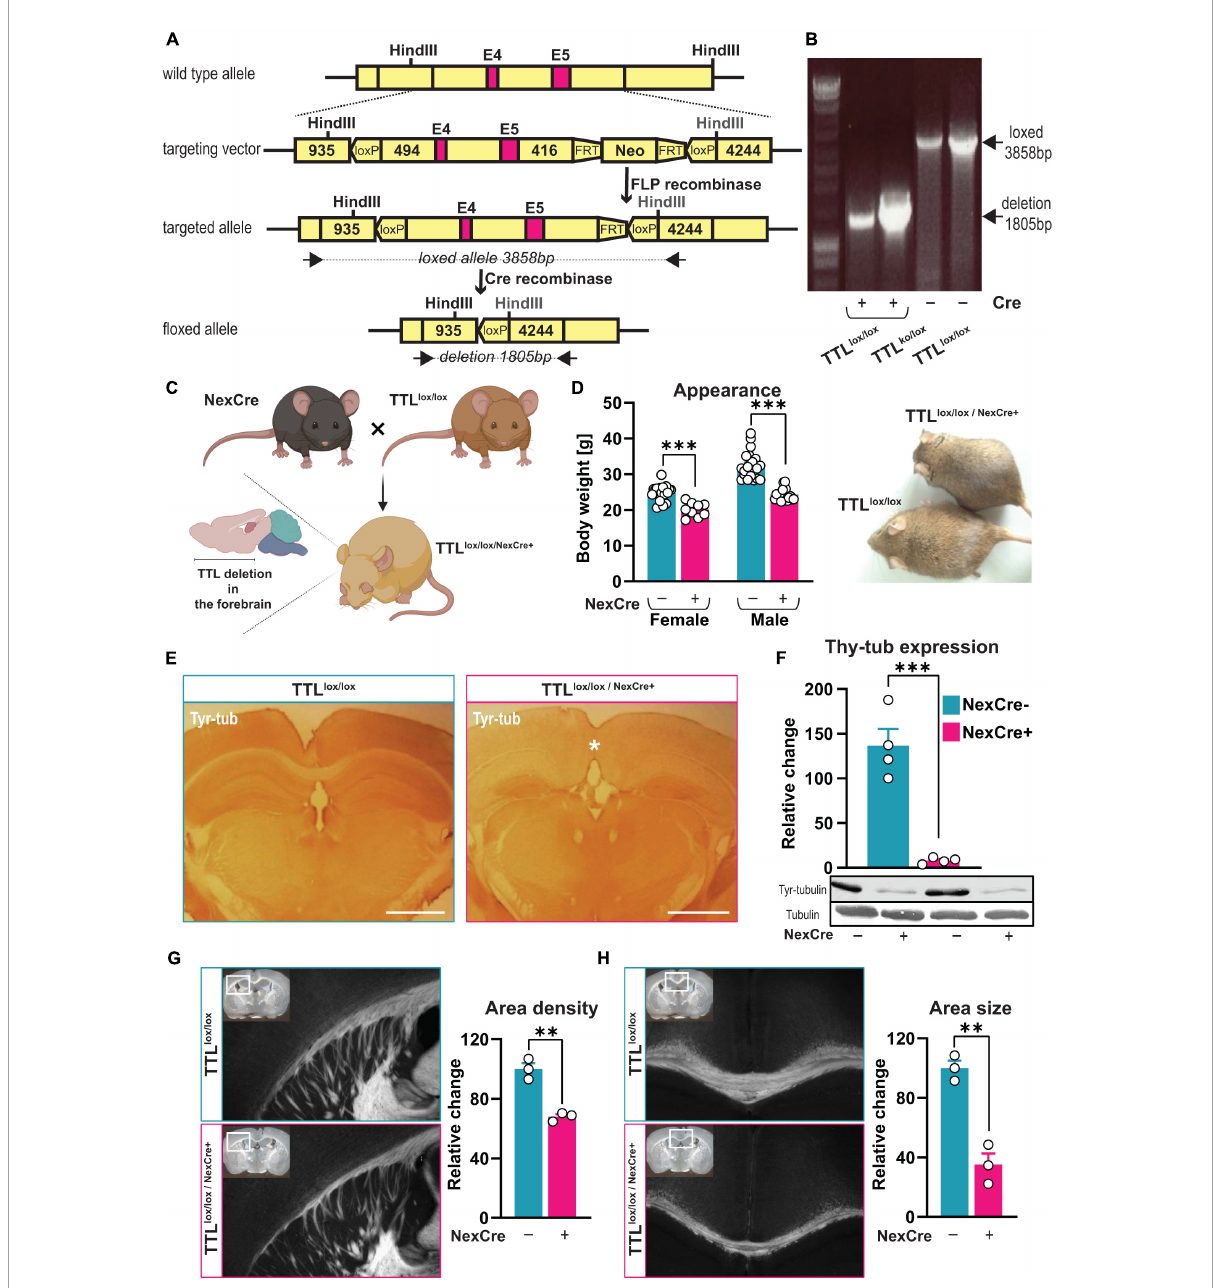
FIGURE1 Generation of a TTL conditional knock-out mouse line. (A) A schematic overview of the targeted allele and the resulting floxed allele. Exons 4 and 5 (E4 and E5) are flanked with loxP sites, and the neomycin cassette (Neo) was removed by FLP recombinase. The floxed allele shows the resulting genomic DNA structure after Cre-recombinase deletion of Exons 4 and 5, leaving one loxP site. Black arrows indicate the oligos used [see panel (B) ]. The indicated Hin dIII sites were used to determine the genomic structures. FRT: FLP-recognition target. (B) Representative image showing the genomic deletion of the target allele. Genomic DNA was isolated from mouse embryonic fibroblasts (MEFs) transduced to express different amounts of Cre-recombinase/EGFP fusion protein (Cre+). PCR was used to detect the deleted floxed allele [1,805 base pairs (bp)]. The 3,858-bp band corresponds to the PCR product of the non-targeted loxP/loxP allele in non-transduced control cells (Cre-). (C) Schematic representation of TTL lox / lox / NexCre + mouse generation (the figure was created using BioRender.com). (D) 10-week-old female and male TTL lox / lox / NexCre + mice displayed lower body weight compared to their control littermates ( n = 9–21, unpaired t -test, p < 0.001). (E) An overview of the decreased levels of tyrosinated α -tubulin in the neocortex and hippocampus of TTL lox / lox / NexCre + mice. Brain sections were immunostained with an antibody against tyrosinated α -tubulin (scale bar = 1 mm). (F) Western blot analysis of cortical extracts from the